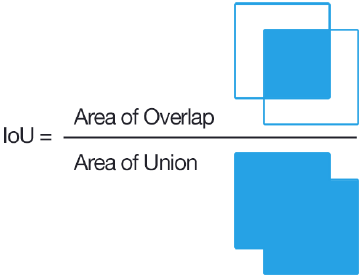
Figure 7. Schematic that shows IoU of two square masks. IoU is defined as the ratio of “the area of the intersection of two segmen- tation masks” to “the area of their union”. Note that for the two squares shown here even an 80% overlap of their edges results in an IoU of 0.47, because the intersection area is 0.64 units and the union is 1.36 units. Source: https://www.pyimagesearch.com/ 2016/11/07/intersection-over-union-iou-for-object-detection/